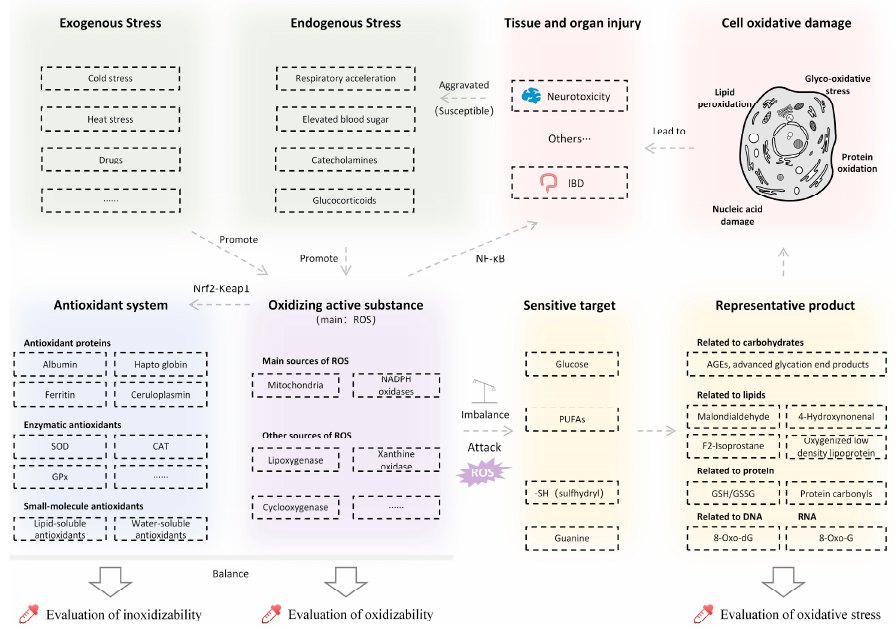
Figure 2. Mechanism and influence of oxidative stress. SOD, superoxide dismutase; CAT, catalase; GPx, glutathione peroxidase; 8-oxo-dG, 8-oxo-2’-deoxyguanosine; 8-oxo-G, 8-oxo-guanine; GSH, reduced glutathione; GSSG, oxidized glutathione disulfide; IBD, inflammatory bowel disease.